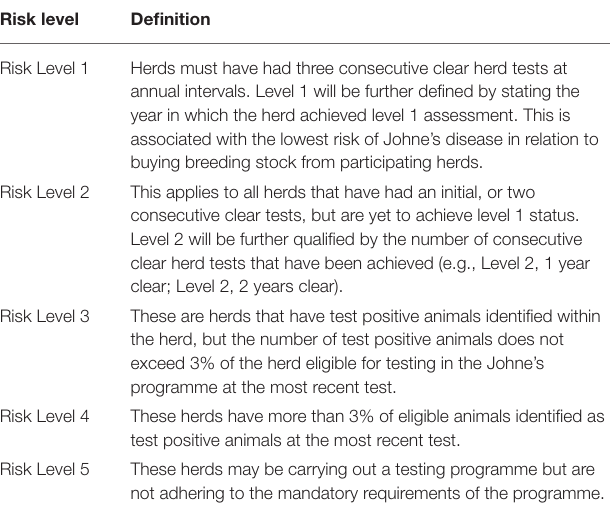
TABLE 2 | Summary of Johne’s risk level